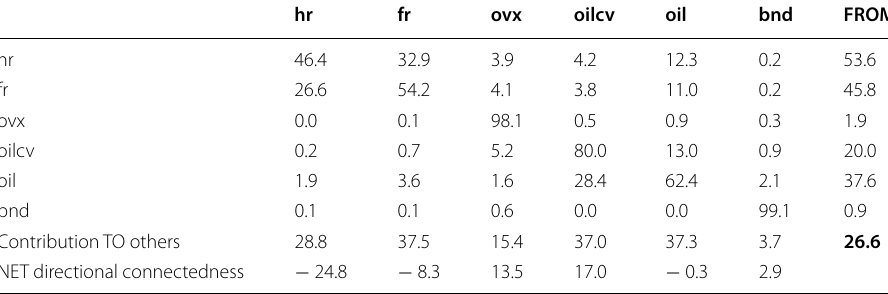
The ij -entry of the upper left 6 6 variable submatrix gives the ij -th pairwise directional connectedness. The rightmost × (FROM) column gives total directional connectedness from all other variables to i variable. The bottom (TO) row gives total directional connectedness to all other variables from j variable. The bottommost (NET) row gives the differencing total directional connectedness (to–from). The bottom right element, in bold, is total connectedness